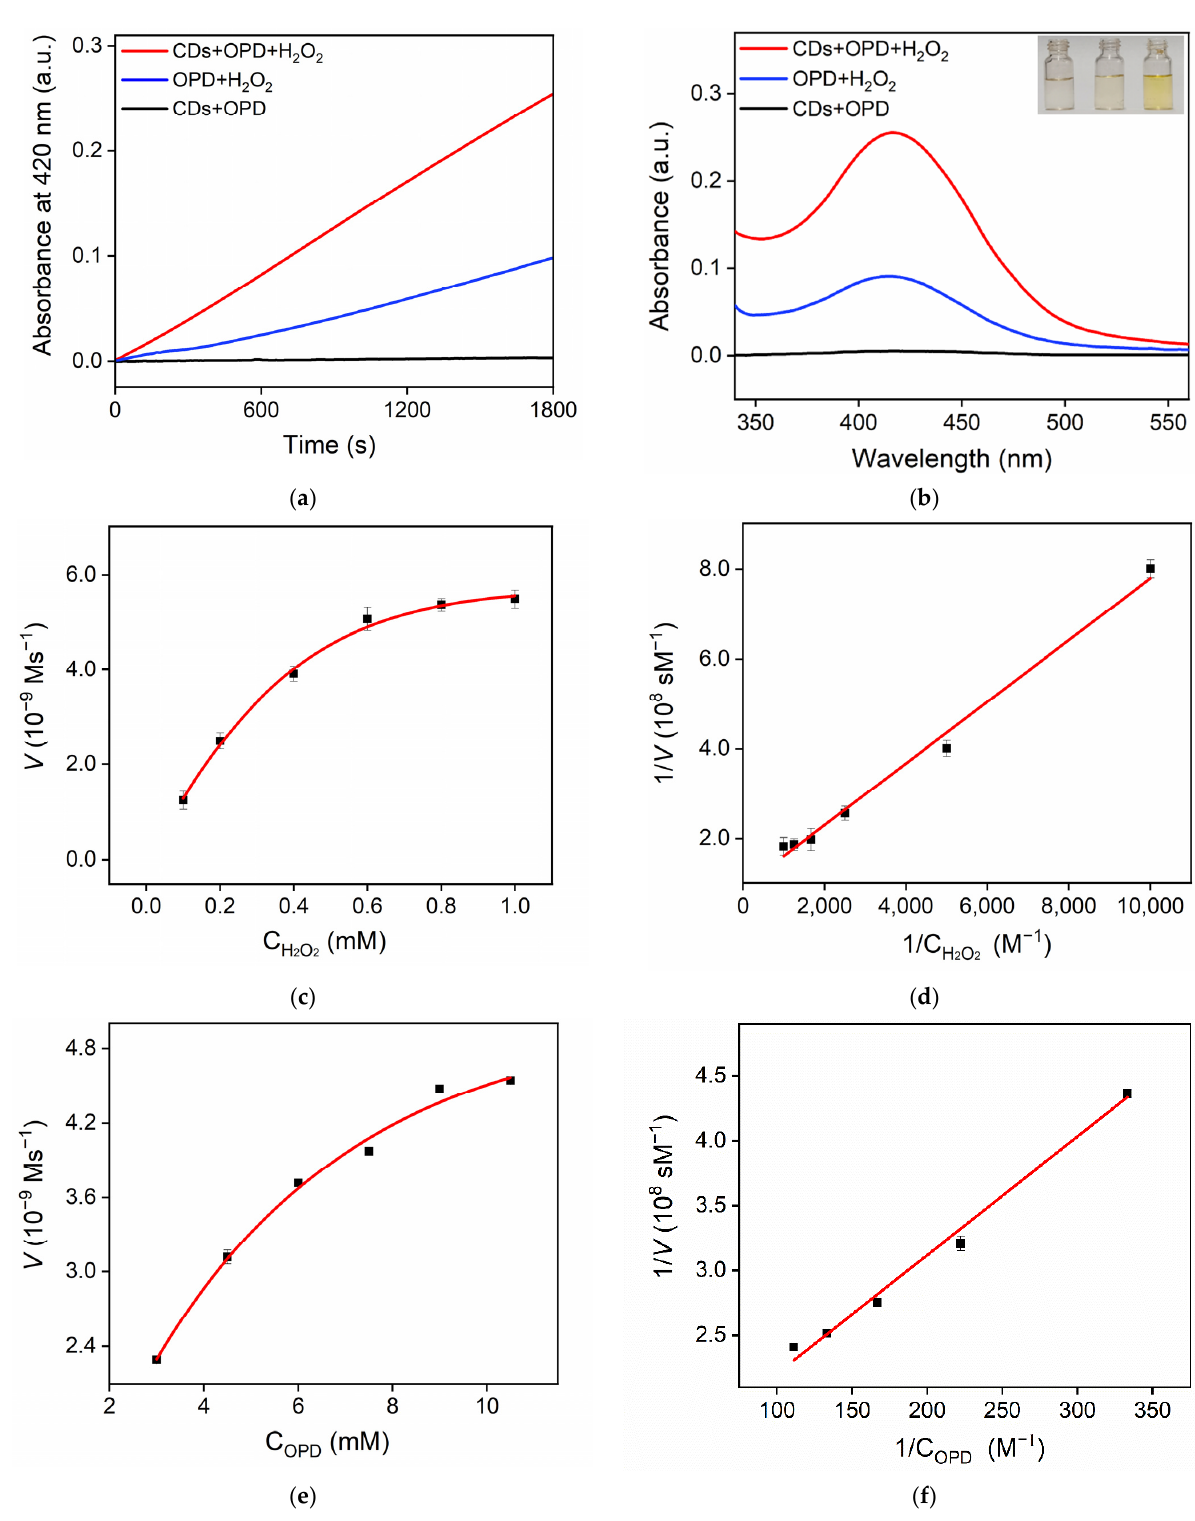
Figure 5. Time-dependent change in A 420 ( a ) and the corresponding absorbance spectra ( b ) of different mixtures after 35 min reaction. Insets in ( b ) are digital photographs of CDs + OPD ( left ), OPD + H 2 O 2 ( middle ), and CDs + OPD + H 2 O 2 . (right) ( c , e ) Steady-state kinetic assay of CDs, in which the reaction velocity was determined through oxidation of OPD based on absorption at 420 nm with varying concentrations of H 2 O 2 ( c ) or OPD ( e ). ( d , f ) Double-reciprocal plots of CD activity obtained using Michaelis–Menten model at different concentrations of H 2 O 2 ( d ) or OPD ( f